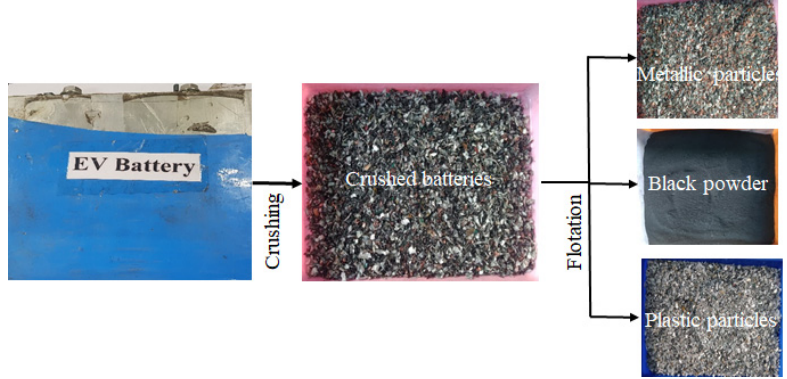
Figure 1. Pre-treatment of discarded electric vehicle batteries. Table 1. Elemental composition by weight (wt. %) of the black power of an NiMH battery used in electric vehicles.